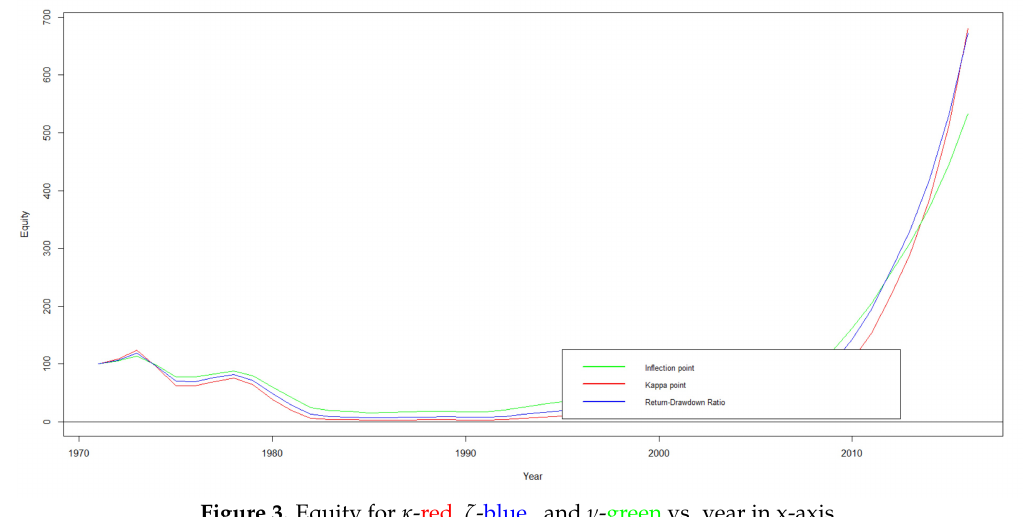
Figure 3. Equity for κ -red, ζ -blue, and ν -green vs. year in x-axis.